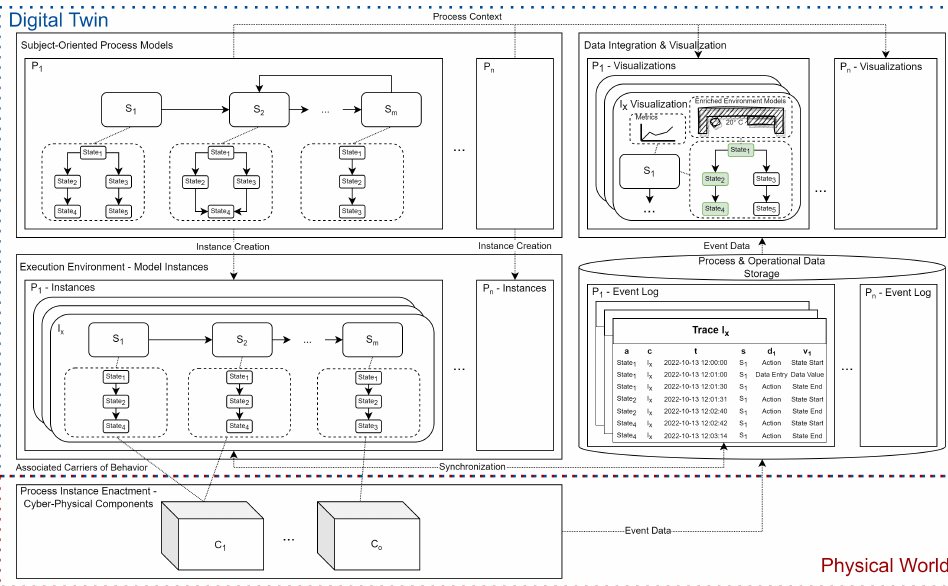
Figure 9. The proposed concept for the creation of digital (process) twins built on ideas from subject- oriented business process management to link behavior with geo-spatial context